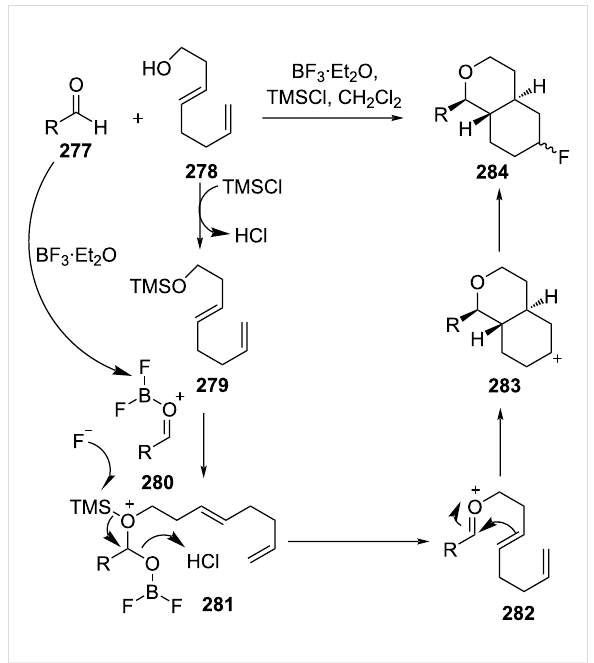
Scheme 66: Sequential reactions involving Prins